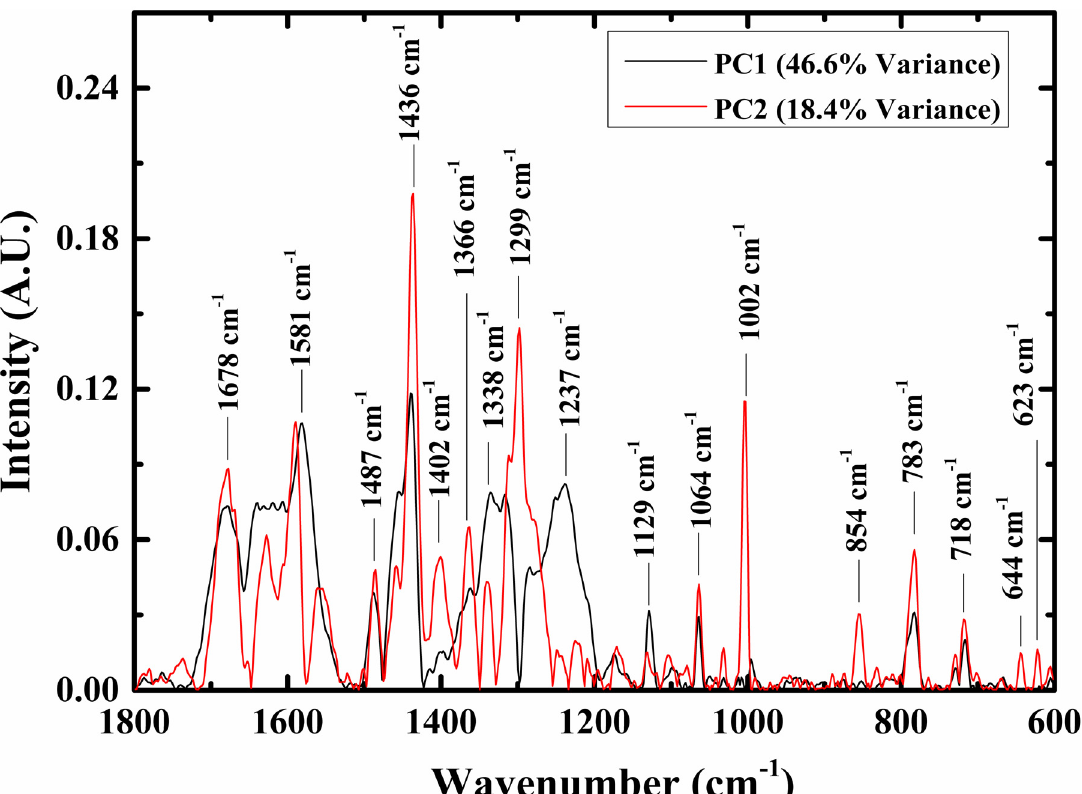
Fig 5. Loadings plots. Loadings 1 and 2 determined using PCA calculations (absolute values) are plotted in the 600 – 1800 cm -1 region. The major peaks and their centroids are displayed in the